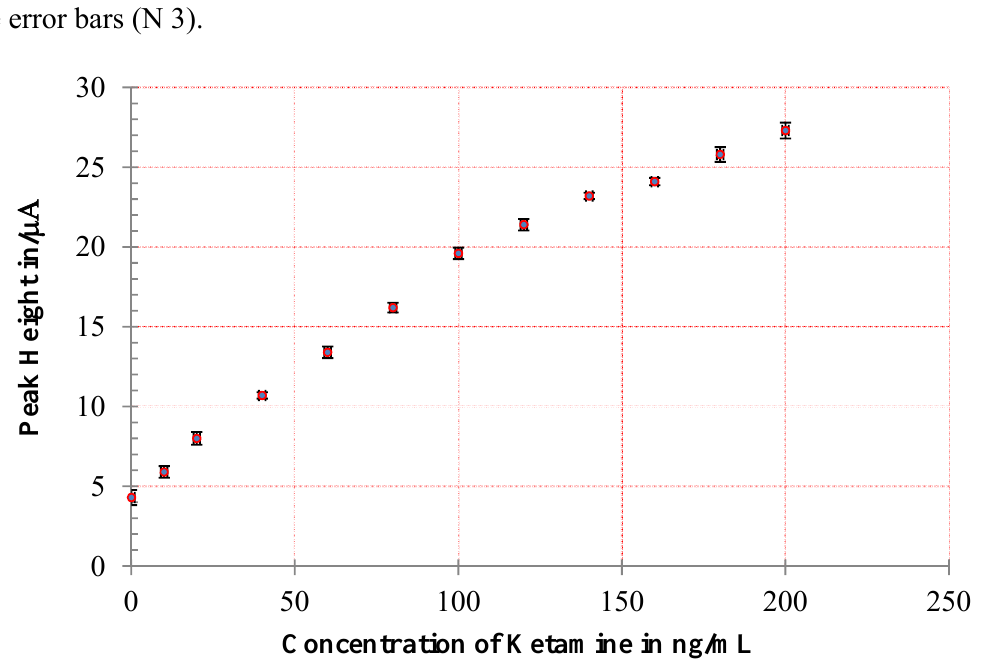
Figure 4. A calibration plot corresponding to the addition of Flunitrazepam into a phosphate buffer pH 6 solution over the concentration range 10–200 ng/mL. Also included are error bars (N